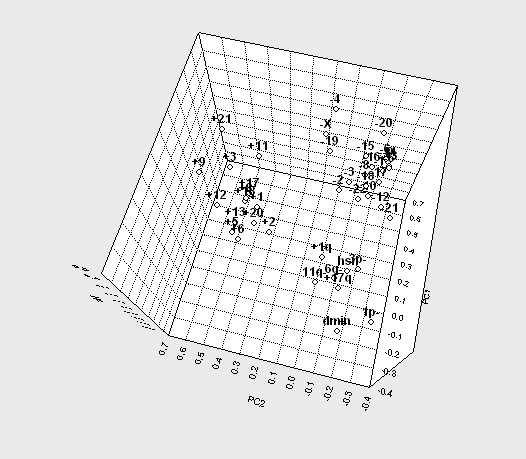
Principal component analysis of recurrent imbalances in neuroblastoma. A three-dimensional representation based on the three first principal components is shown. Three major clusters of imbalances are seen; one composed of all structural aberrations, one containing all whole chromosome gains, and one with all whole chromosome losses. PC1, PC2, PC3 are principal components 1, 2, and 3, respectively.